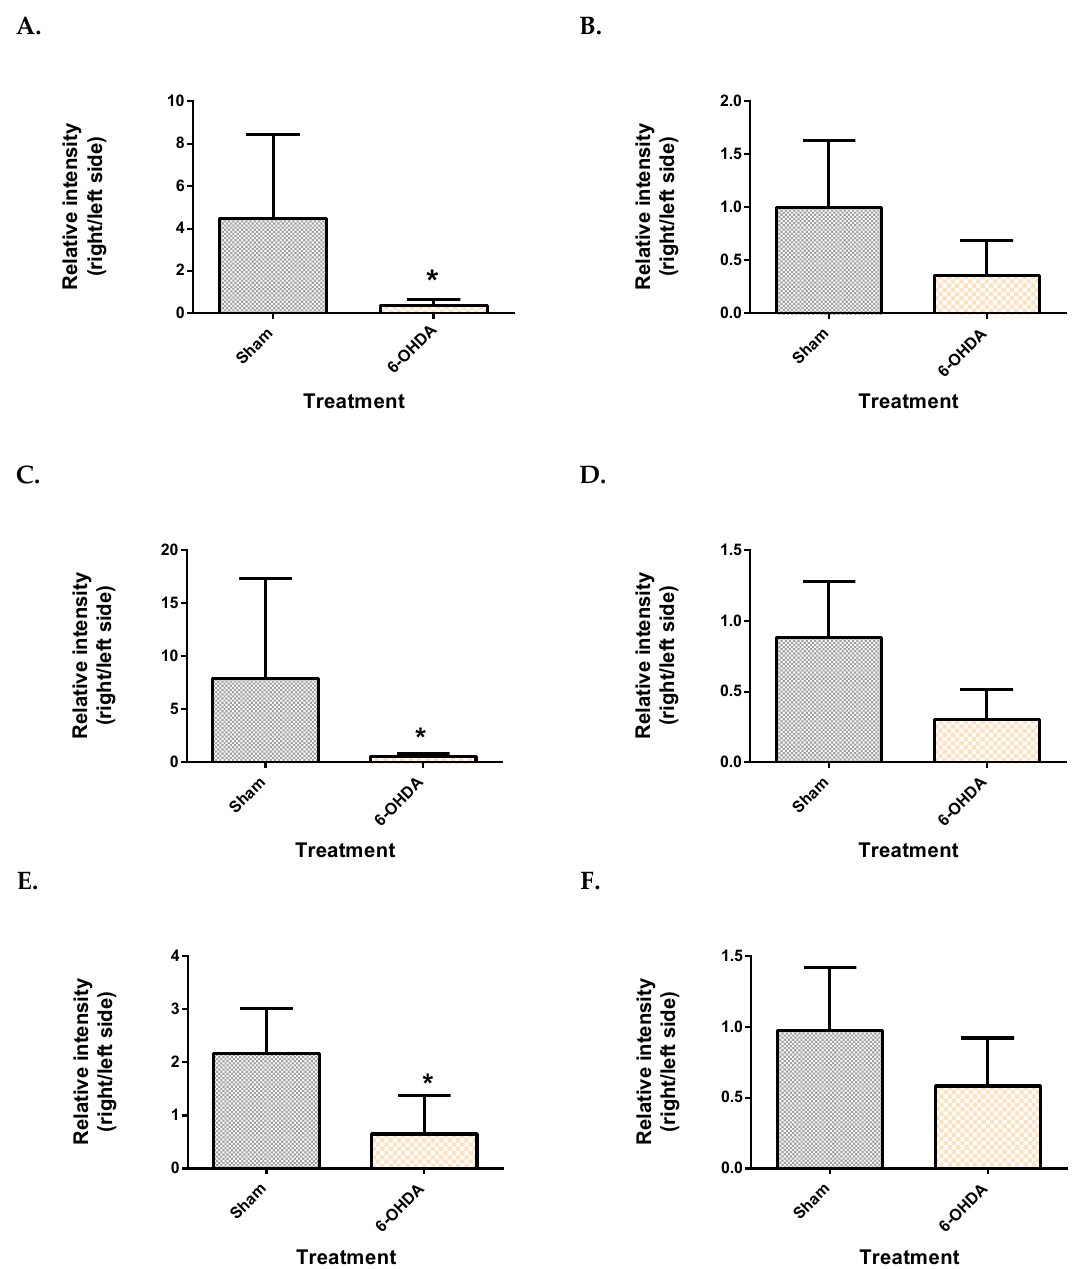
Figure 3. Comparison of brain metabolite changes between the mesencephalon and cerebellum. Midbrain monopalmitin ( A ), monostearin ( C ) myo-inositol ( E ) were significantly altered while cerebellar monopalmitin ( B ), monostearin ( D ), myo-inositol ( F ) and) were unchanged. Data represent mean ± S.D of at least 5 animals in each group. (* indicates q value < 0.05 using Mann–Whitney test, followed by Benjamini–Hochberg correction).